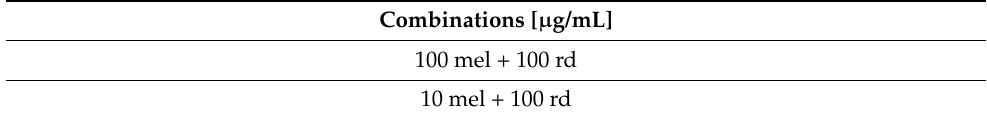
Table 2. Drug combinations used in TUNEL assay: mel-meloxicam, +rd-risedronate